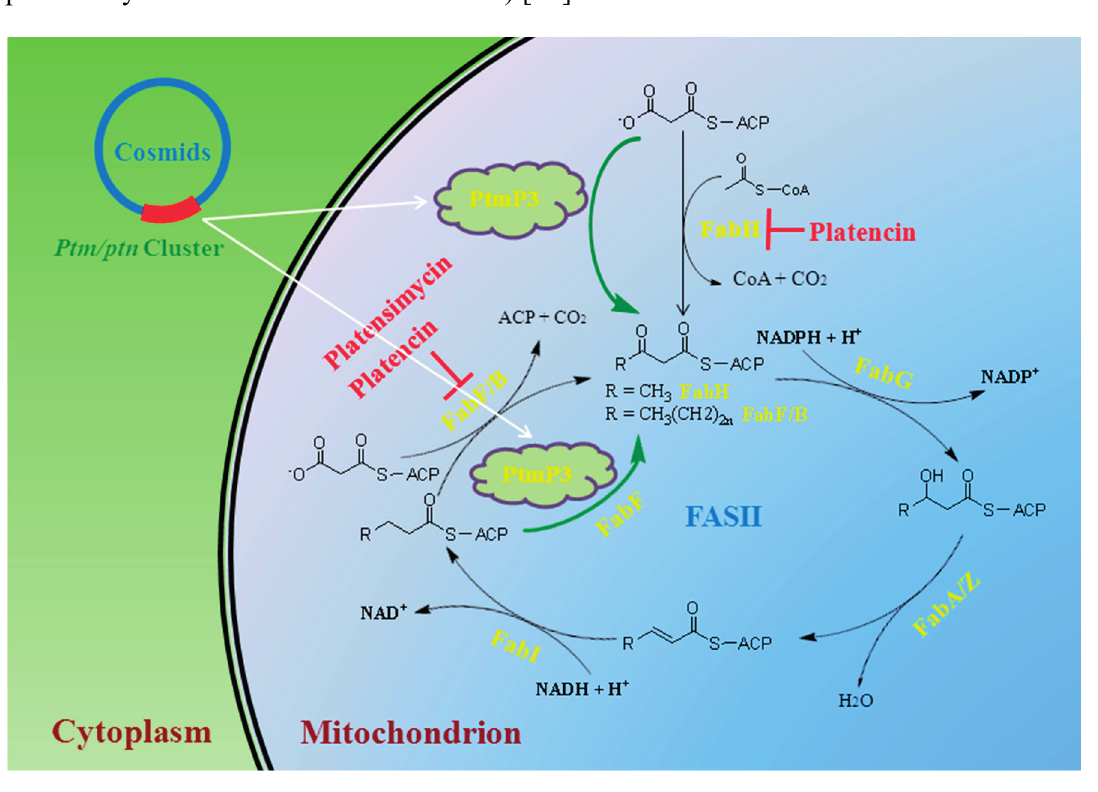
Figure 2. A diagram of the bacterial fatty acid synthesis cycle (FASII). Highlighted in red are (i) platensimycin inhibiting FabF/B and platencin dually inhibiting FabF and FabH, and (ii) the two complementary mechanisms of platensimycin and platencin resistance in S. platensis by target replacement and target modification. Adapted from Peterson et al.